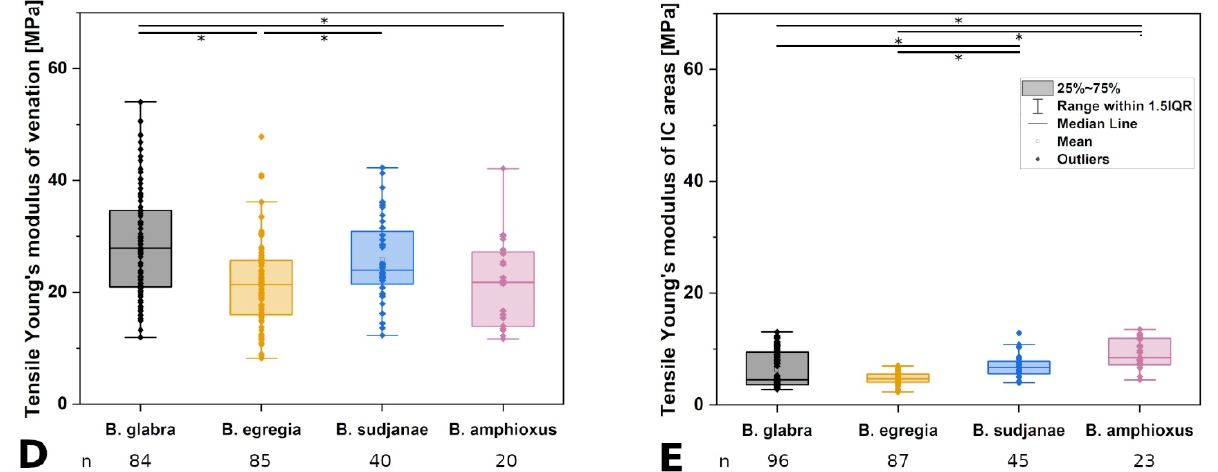
Figure 4. Comparison of mechanical leaf variables in different Begonia species. Tensile ( A ) and flexural ( B ) Young’s moduli of petiole in MPa, flexural rigidity of petiole ( C ) in Nmm 2 , tensile Young’s moduli of venation ( D ), and intercostal areas ( E ) in MPa of Begonia glabra , B. egregia , B. sudjanae, and B. amphioxus . The box represents data between first and third quartile. Whiskers include data points within 1.5 × of the interquartile range. The median is marked with a line, the mean with a square. Asterisks (*) mark significant differences between species analyzed via Kruskal–Wallis ANOVA. For each species, the sample size (n) is shown below the species name. p -values are shown in Table 2. All samples were taken from one plant per species (two for B. sudjanae